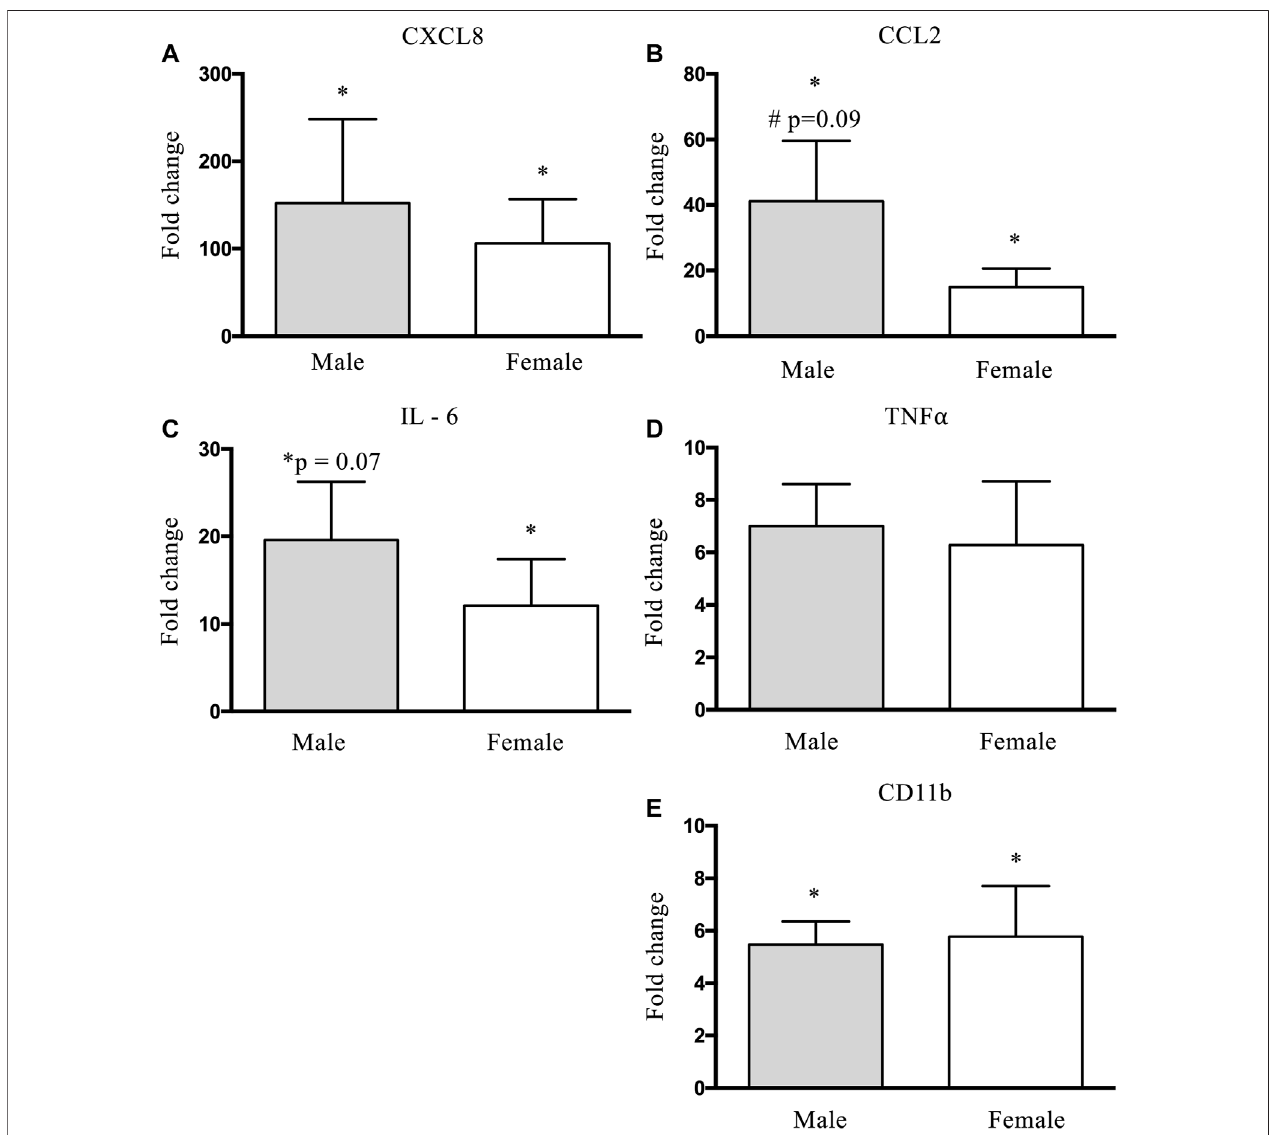
FIGURE6| ChangesinCXCL8 (A) ,CCL2 (B) ,IL-6 (C) ,TNF α (D) ,andCD11b (E) mRNAexpression before(pre-)and48 h(post)followingeccentricdamage.Fold changes for mRNA expression were calculated using the 2 − ΔΔ C t method with genes of interest normalized to GAPDH. * indicates signi fi cant effect of time ( p < 0.05). # indicates signi fi cant time × group interaction; an increase from pre-exercise value is smaller in females compared with males ( p < 0.05).